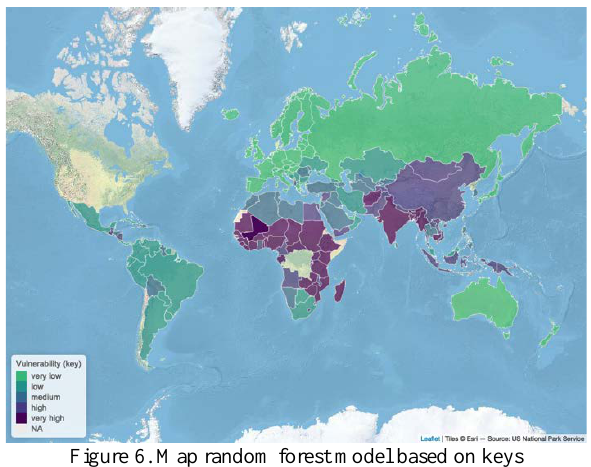
Figure 6. Map random forest model based on keys